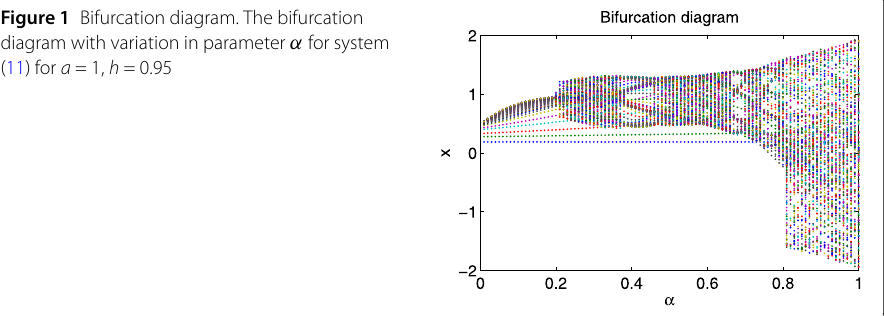
Figure 1 Bifurcation diagram. The bifurcation diagram with variation in parameter α for system (11) for a = 1, h =